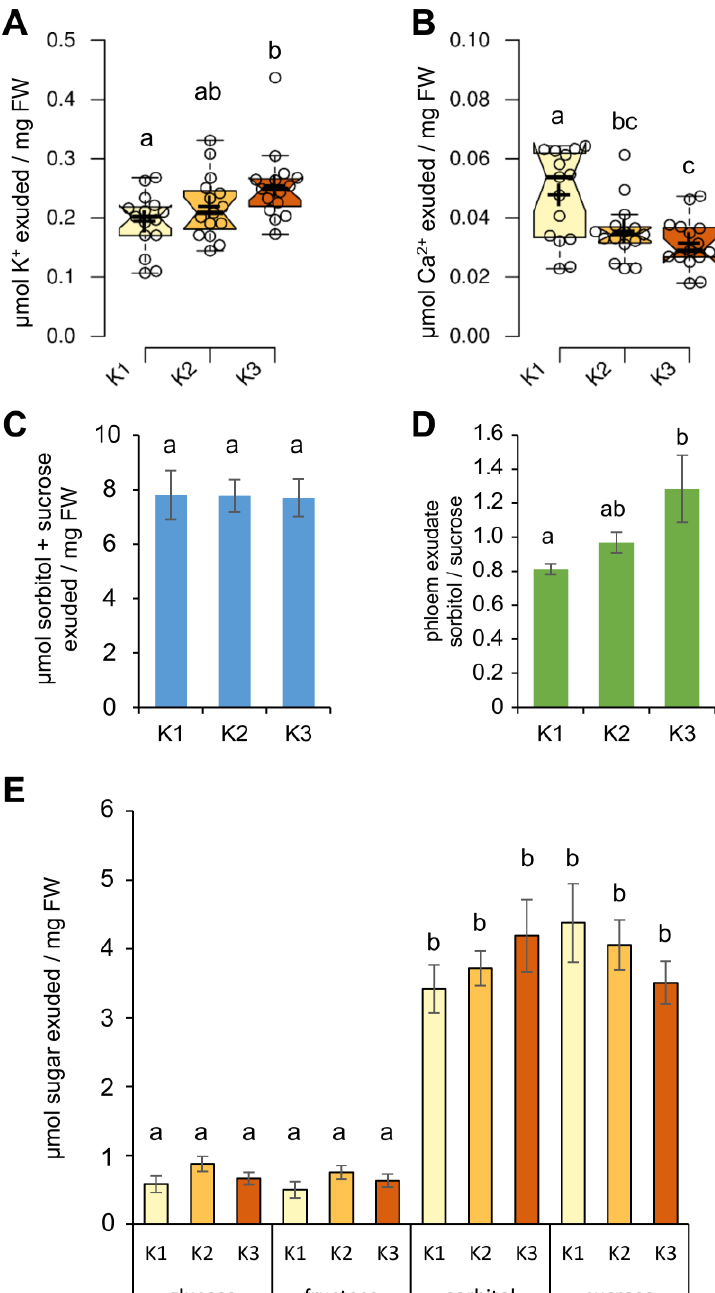
Figure 5. Effect of different soil K levels on phloem exudates. ( A ) K + level; ( B ) Ca 2+ level; ( C ) sum of sorbitol and sucrose; ( D ) sorbitol to sucrose ratio, and ( E ) sugar profile in phloem. Boxplots are based on values from n = 15 plants per soil K level. Center lines within boxes represent median, and crosses are mean values. The notches are defined as +/ − 1.58 × IQR/sqrt ( n ) and represent the 95% confidence interval for each median. Bars are means from n = 15 replicates ± SD. Different letters indicate significant di ff erences between K conditions, according to the one-way ANOVA with post-hoc Tukey HSD test ( p <